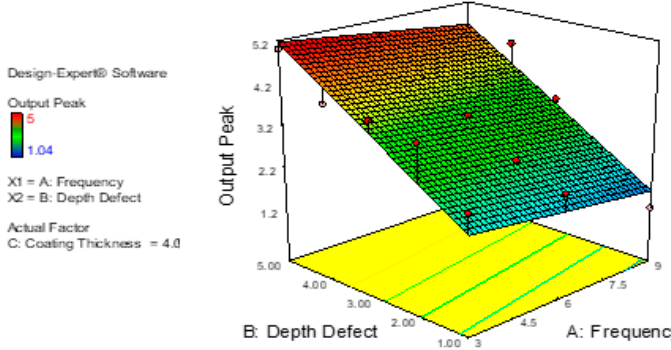
Figure 18. Relations between Depth of Defect, Frequency and Output Peak.